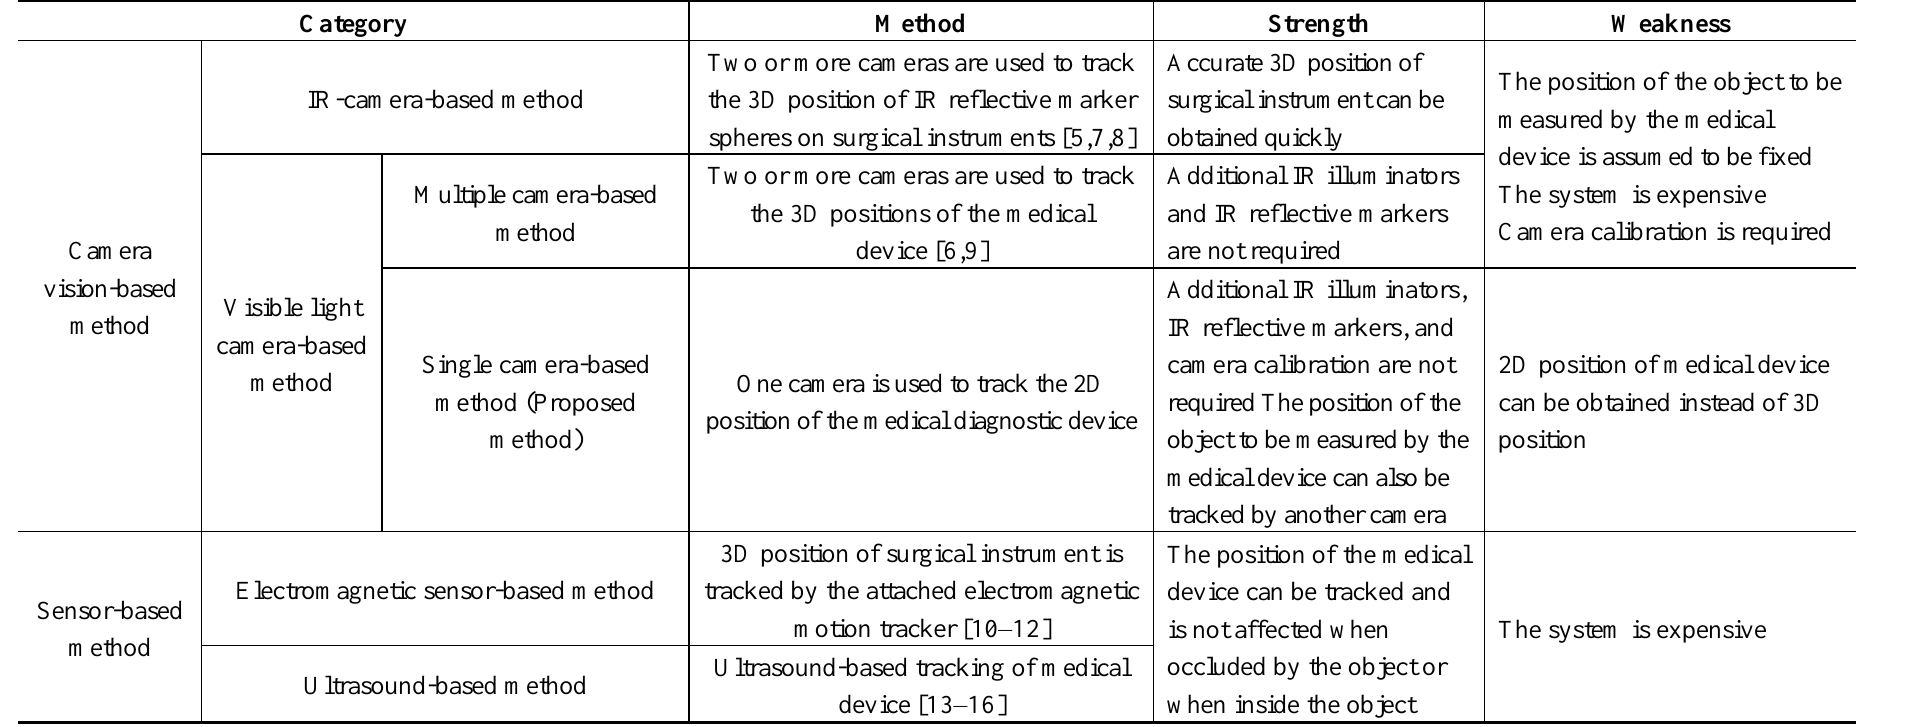
Table 1. Comparison between proposed method and previous methods for tracking medical